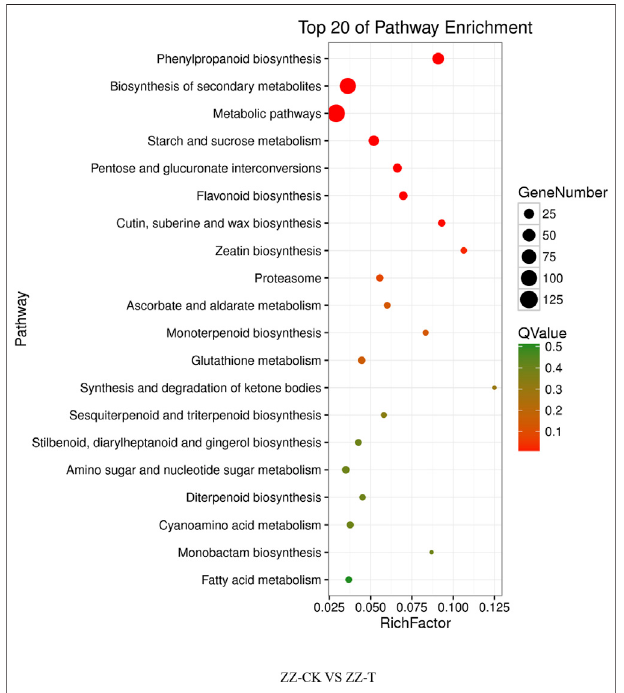
FIGURE 7 | KEGG pathway of seeding tea plants under drought on day 0andday20.QC,Cuttingteaplant.CK:Cuttingsamplestreatedwithdrought for 0 days, T: Cutting samples treated with drought for 20 days.